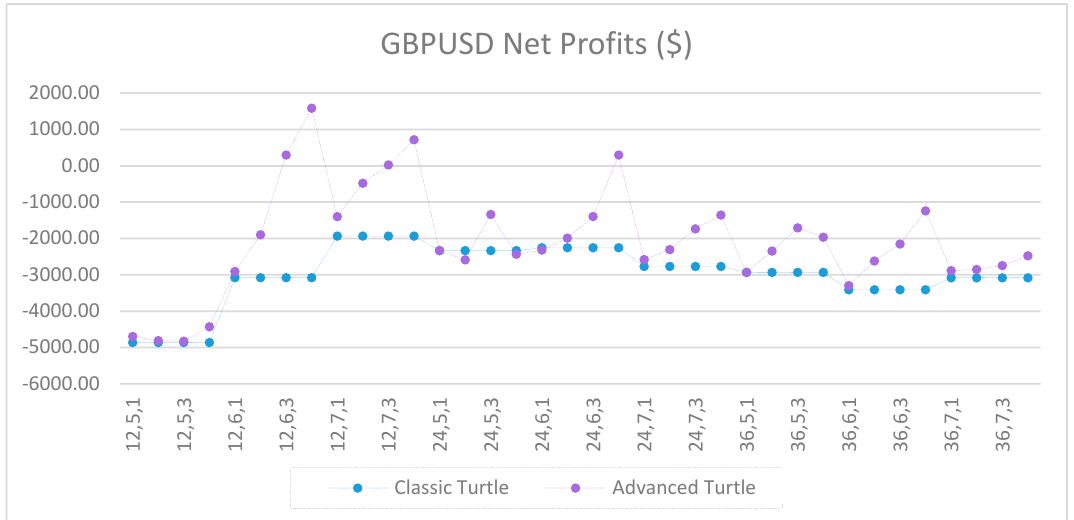
Figure A53. Net profits of GBPUSD between the classic and the advanced Turtle systems for every combination of N, X, Y for the slow parameters (80, 160), where X ≥ 5.